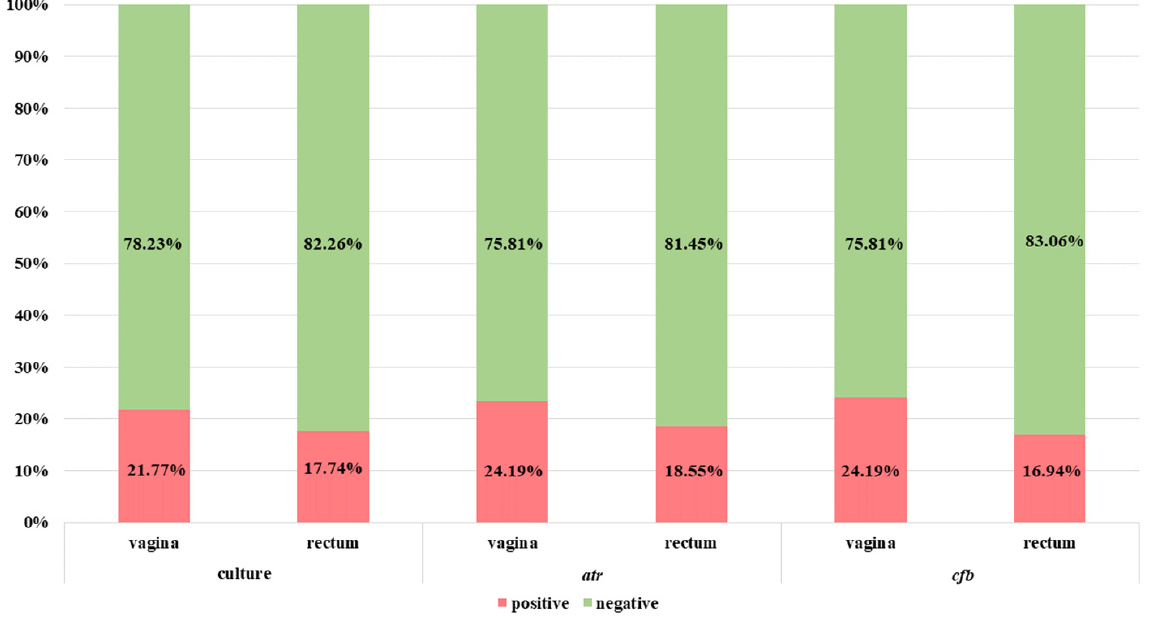
Figure 6. The comparison of GBS identification results using the culture method with preincubation in enrichment broth and NAAT-based methods with preincubation based on the atr gene (conven- tional PCR) and cfb gene (real-time PCR).